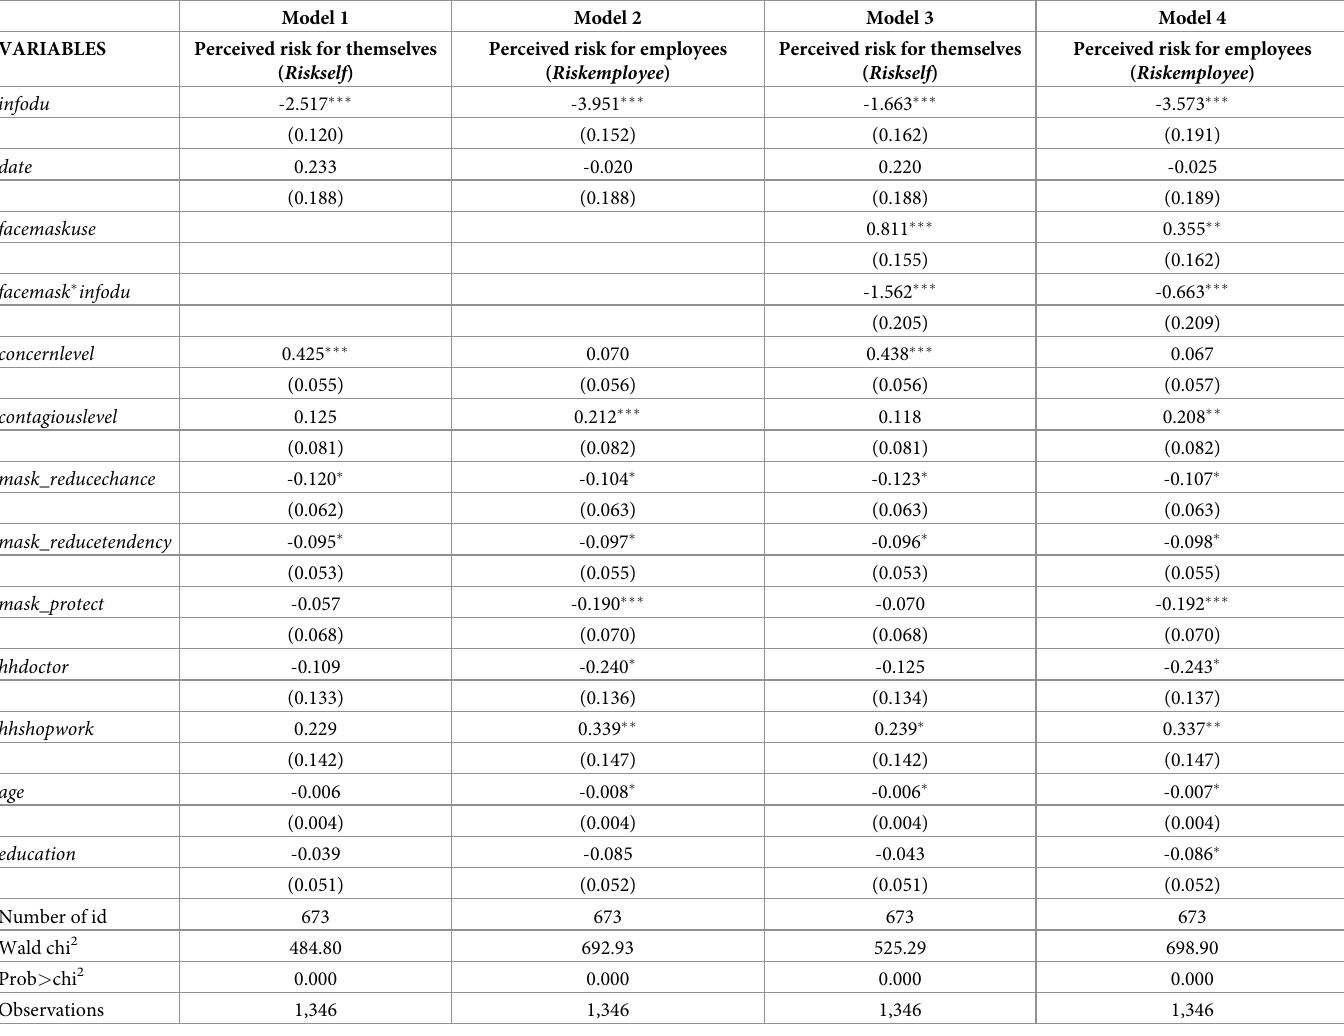
Table 2. Panel data ordered logistic regression results of risk